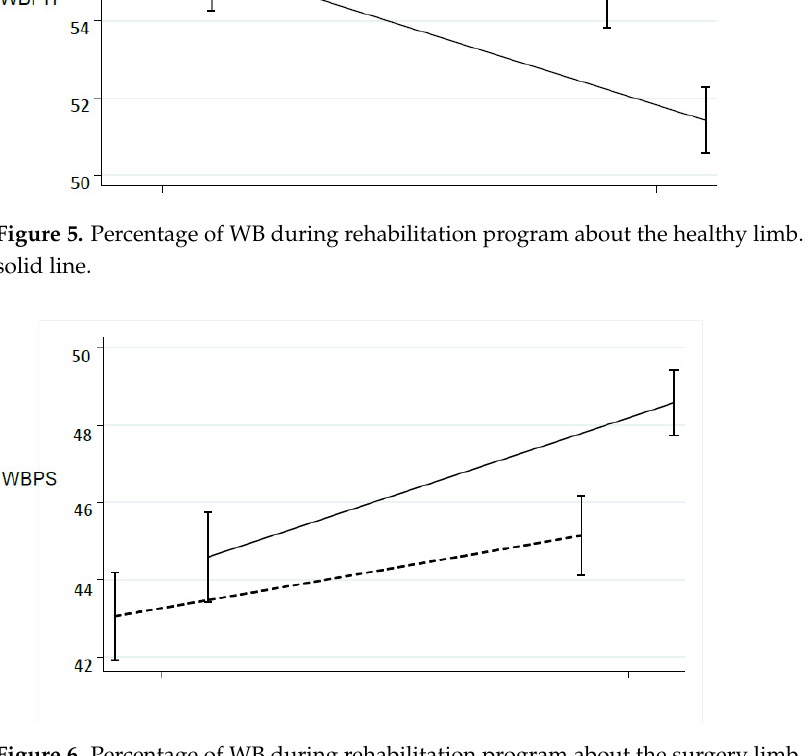
Figure 6. Percentage of WB during rehabilitation program about the surgery limb. CG: dot line; EG: solid line.